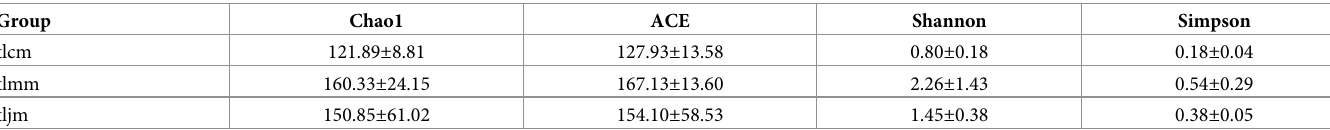
Table 1. Alpha diversity indices of the bacterial lactase gene from the intestinal mucosa of antibiotic-associated diarrhea mice treated with D . hansenii .